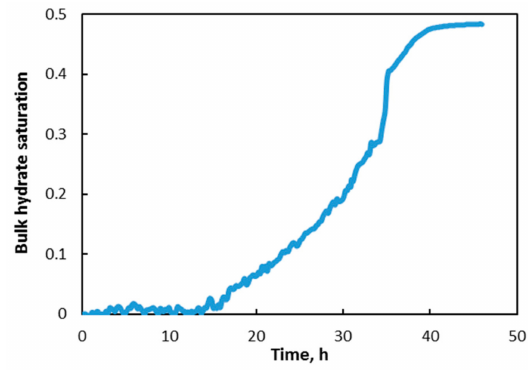
Figure 7. Variation of bulk hydrate saturation in